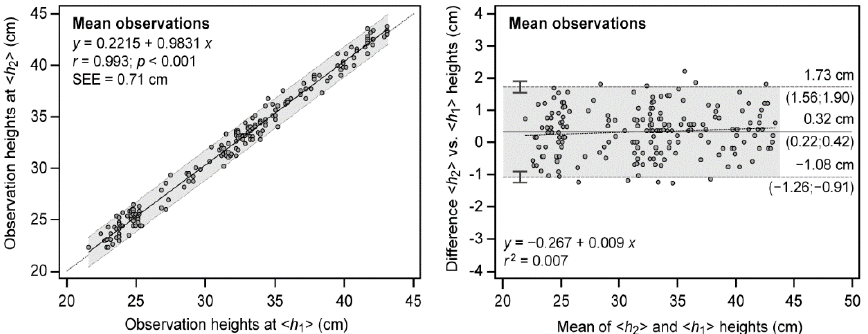
Figure 4. Method agreement between mean observations derived from the two observation heights h 1 and h 2 . Relationship between observations ( left ) and Bland-Altman plots ( right ) are shown. For regression, dotted line represents linear regression; upper and lower dashed lines show 95% confidence intervals. Predictive linear regression equations, Pearson’s product-moment correlation coefficient ( r ) and standard error of estimate (SEE) are also depicted. For Bland–Altman, solid central line represents the mean between observations (systematic bias); upper and lower dashed lines show mean ± 1.96 SD (random error) with CI-95% limits in parentheses; dotted line depicts linear regression (proportional bias). Linear regression equations of the differences and determination coefficient r 2 are also shown to inspect bias proportionality.